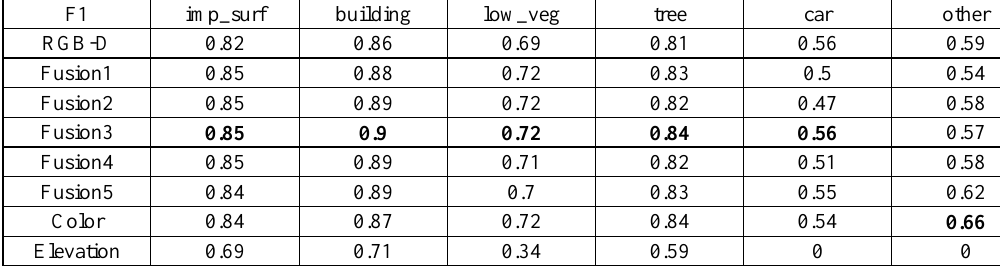
Table 4. Class-wise F1 score of six classes for fusion models.